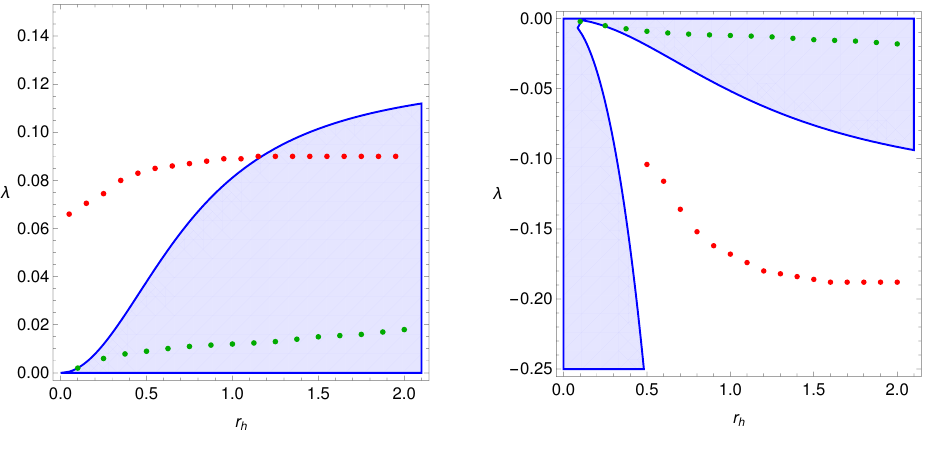
Figure 11. Constraints on the parameter space ( r h ; (cid:21) ) of the spherical AdS Gauss-Bonnet black hole soluton due to: hyperbolicity (Blue), boundary causality [34] (Red), and Causal Wedge Inclu- sion (Green). The region outside the shaded region or above (below in the right (cid:12)gure) the dots is not allowed.